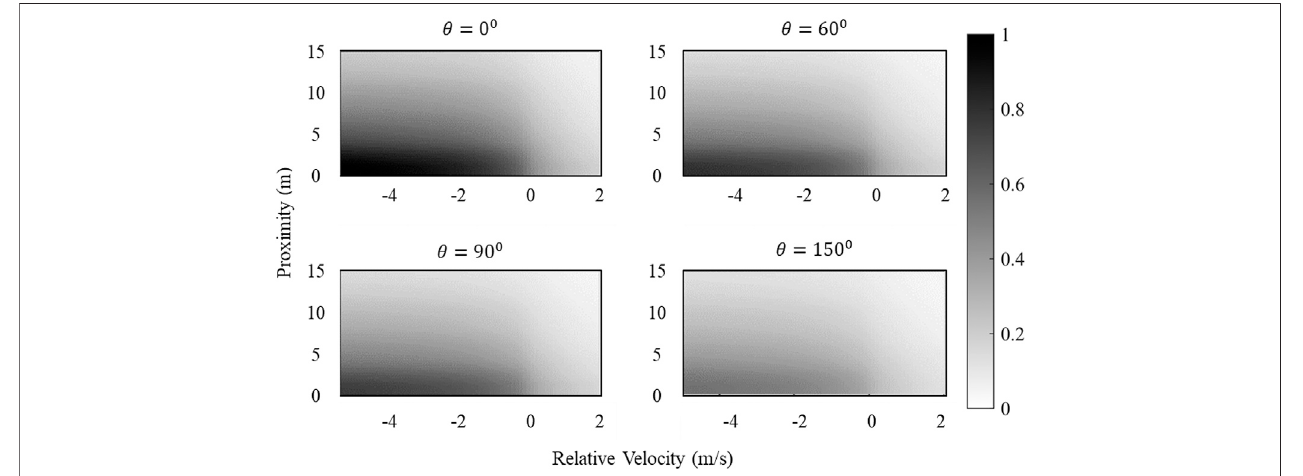
FIGURE 6 | An example of multivariate CDF (EV is Car; Obstacle is